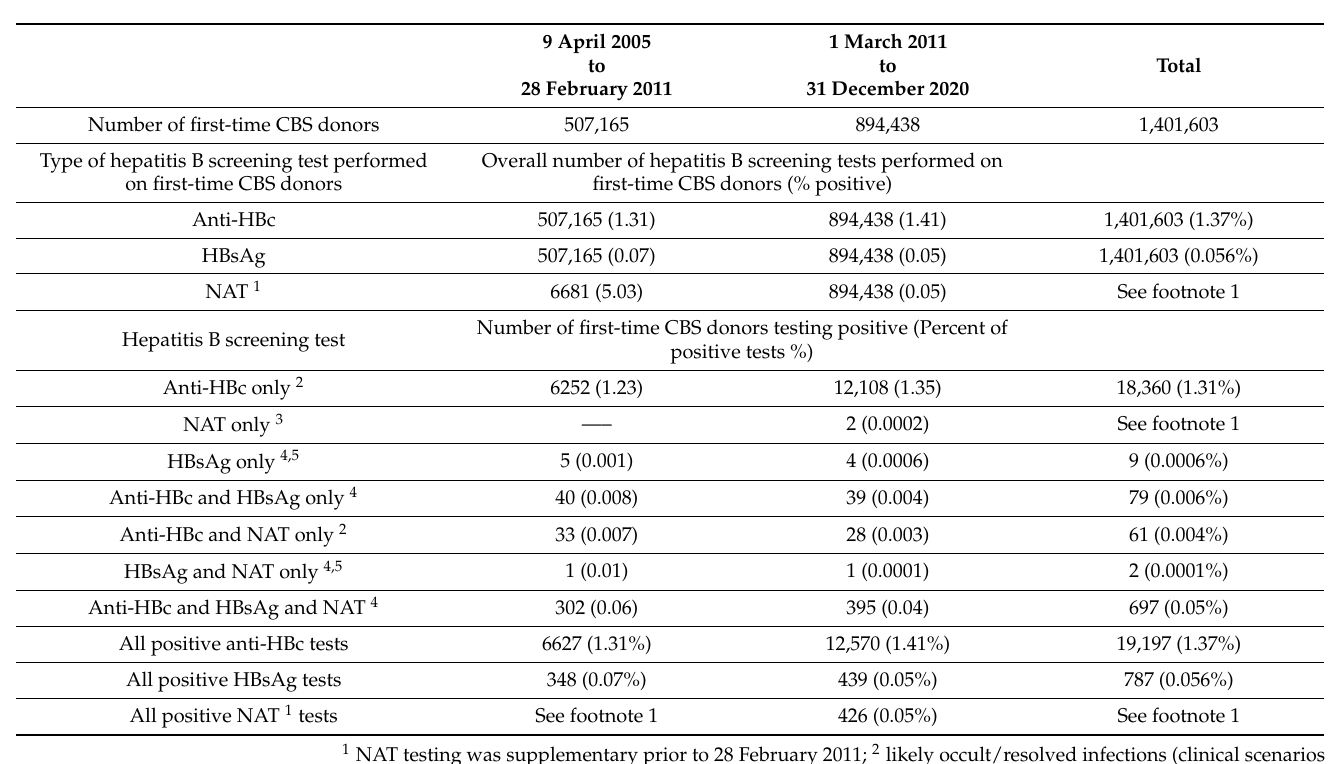
Table 5. Breakdown of hepatitis B marker (anti-HBc, HBsAg, HBV NAT) test results among first-time donors (2005–2020).